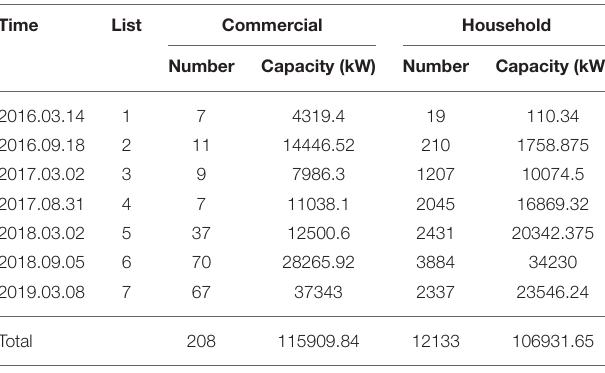
TABLE 1 | Beijing DPV power generation project award